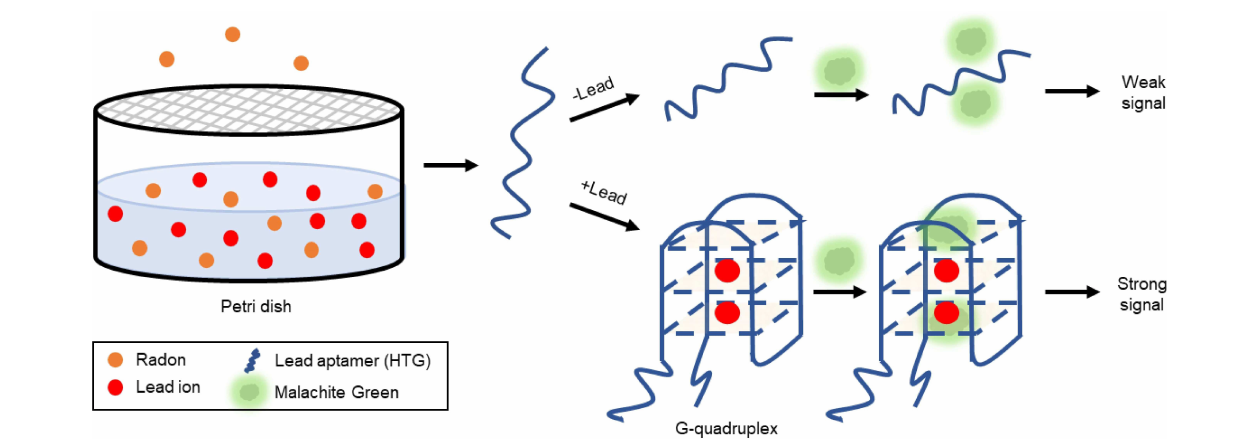
presence of lead ion, the G-rich aptamer (T30695) underwent a structural transition to a G-quadruplex (Khoshbin et al.,